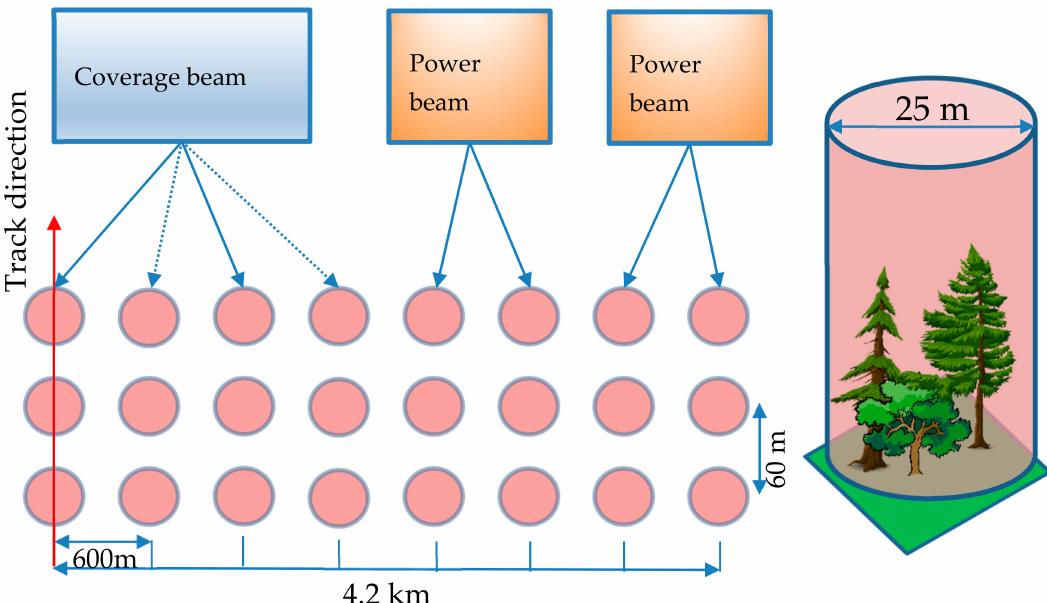
Figure 2. Showing operation of GEDI